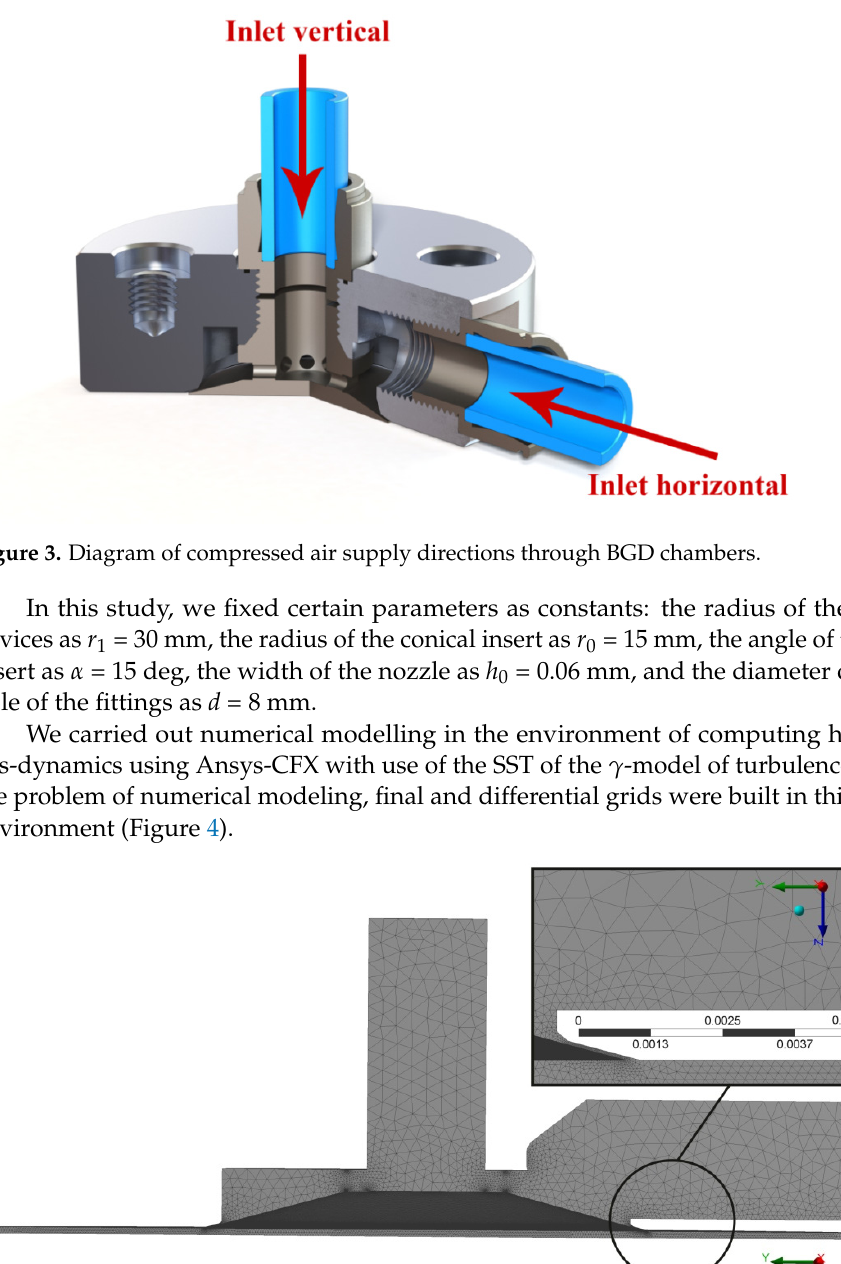
( b ) Figure 5. Extreme conditions for air flow models: ( a ) vertical inlet; ( b ) horizontal inlet. Using the SonicTurbFoam solver (for turbulent streams of the compressed gases moving with sound and supersonic speeds), one can obtain the value of the distribution of teak, speed, and force over the surfaces of the studied model. For further analysis of the obtained results of modeling and theoretical research, the results of the pressure dis- tribution on the surface of the object manipulation are shown in Figure 6.